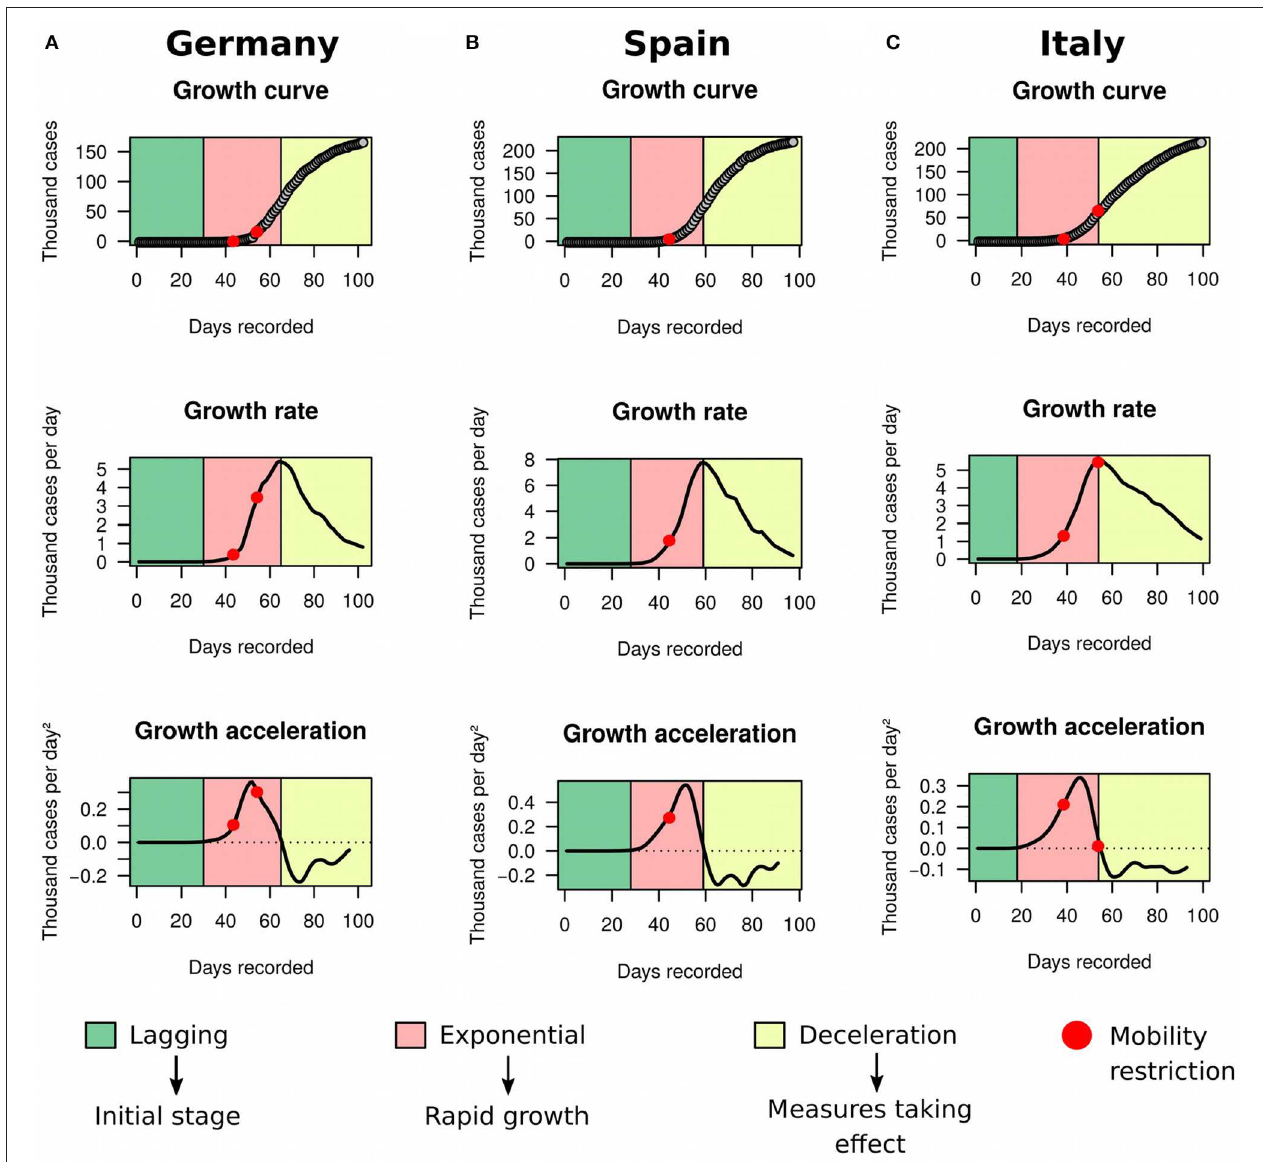
FIGURE 5 | Growth rate and acceleration in Germany, Spain and Italy. These three countries were in deceleration as of May 8th. (A) Germany determined school closing in early March (first red dot) and extended restrictions to movement and gatherings within the country by March 22nd (second red dot). (B) Spain declared state of emergency on March 14th (red dot). Acceleration decline started 1 week later. (C) Italy imposed a strict quarantine on March 10th 2020 (first red dot) and closure of borders on March 25th 2020 (second red